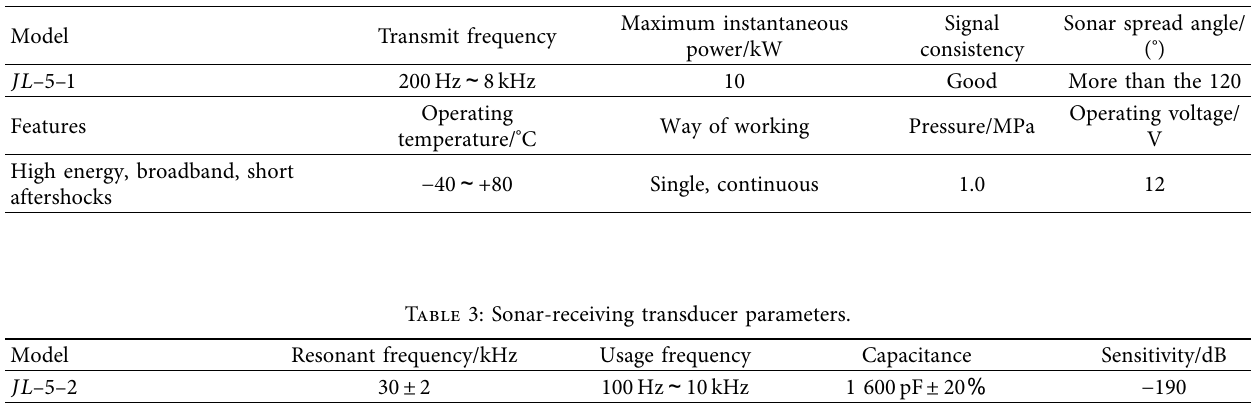
Table 2: Parameters of a sonar transmitting transducer.